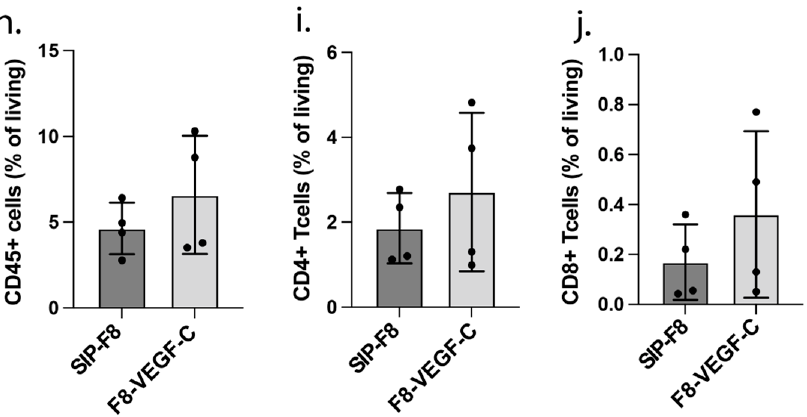
Figure 2. ( a ) Representative images taken by the in vivo imaging system (IVIS), showing the clearance of an intradermally injected near-infrared tracer (P20D800) that is exclusively drained by lymphatic vessels in K14-VEGF-A transgenic mice, previously treated with either F8-SIP or F8-VEGF-C, on day 74 after challenge. ( b ) Clearance rate and ( c ) half-life analysis of the P20D800 tracer in F8-SIP and F8-VEGF-C-treated mice 74 days post-challenge (expressed as mean clearance rate resp. half-life, n = 4 mice per group, two-tailed Student’s t -test). ( d , e ) Representative immunofluorescence images of ear sections from F8-SIP and F8-VEGF-C-treated mice stained for CD45 (red, ( d )) and quantification of the CD45 + area in the region of interest of F8-SIP and F8-VEGF-C-treated mice after resolution of inflammation (( e ), expressed as mean %, n = 8–9 mice per group, two-tailed Student’s t -test). ( f , g ) Representative immunofluorescence images of CD68 (green, ( f )) and quantification of the CD68 + area in the region of interest ( g ) of F8-SIP and F8-VEGF-C-treated mice after resolution of inflammation (expressed as mean %, n = 8–9 mice per group, two-tailed Student’s t -test). Dotted yellow line: basement membrane (BM). Size bars: 50 µ m. ( h – j ) Flow cytometry-based quantification of ( h ) CD45, ( i ) CD4, and ( j ) CD8-positive cells in F8-SIP and F8-VEGF-C-treated VEGF-A transgenic mice 74 days post-challenge (expressed as % of all living cells, n = 4 mice per group, two-tailed Student’s t -test). All data are presented as mean ±